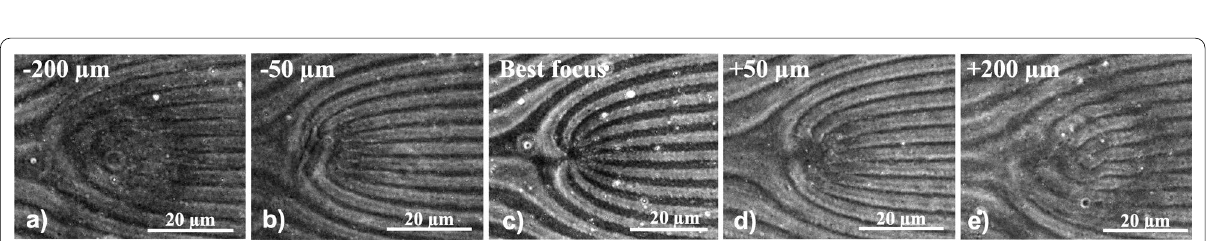
Fig. 7 Phase contrast microscopic images (contrast enhanced) showing the printed accuracy being affected by sample position with respect to best focus. a , d 200 μm away from best focus, b , d 50 μm away from best focus and c at best